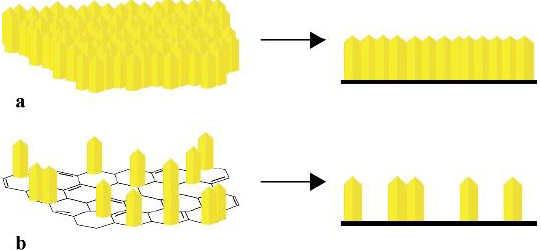
Figure 13. Illustration of α -FeOOH nanorods’ growth on the rGO surface: ( a ) α -FeOOH / rGO 1 and ( b ) α -FeOOH / rGO 2. Top view (left) and front view (right).